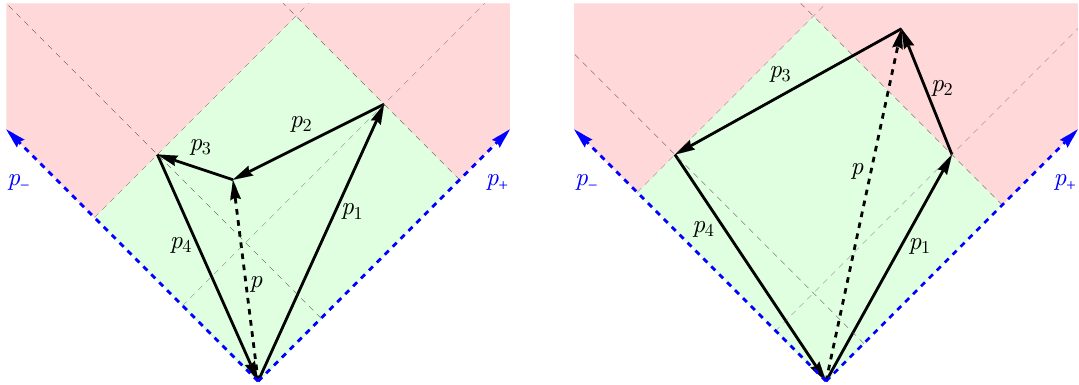
Figure 2 . Two possible con(cid:12)gurations of momenta. The Wightman 4-point function is non-zero p 4 lie in the forward light cone (shaded region), which is the only if all three momenta p 1 , p and (cid:0) case here. The criterion for pointwise OPE convergence is that p lies in the diamond delimited by p 1 and p 4 (green region). The OPE is therefore pointwise convergent for the con(cid:12)guration in the (cid:0) left panel, but not for the con(cid:12)guration in the right